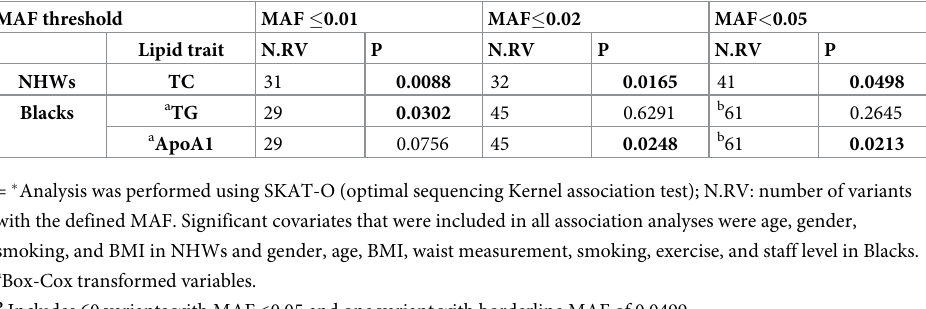
Table 3. Significant results for rare/uncommon variants (MAF < 5%) association analysis � with lipid traits in NHWs and ABs. MAF threshold MAF � 0.01 MAF � 0.02 MAF < 0.05 Lipid trait N.RV P N.RV P N.RV P NHWs TC a TG